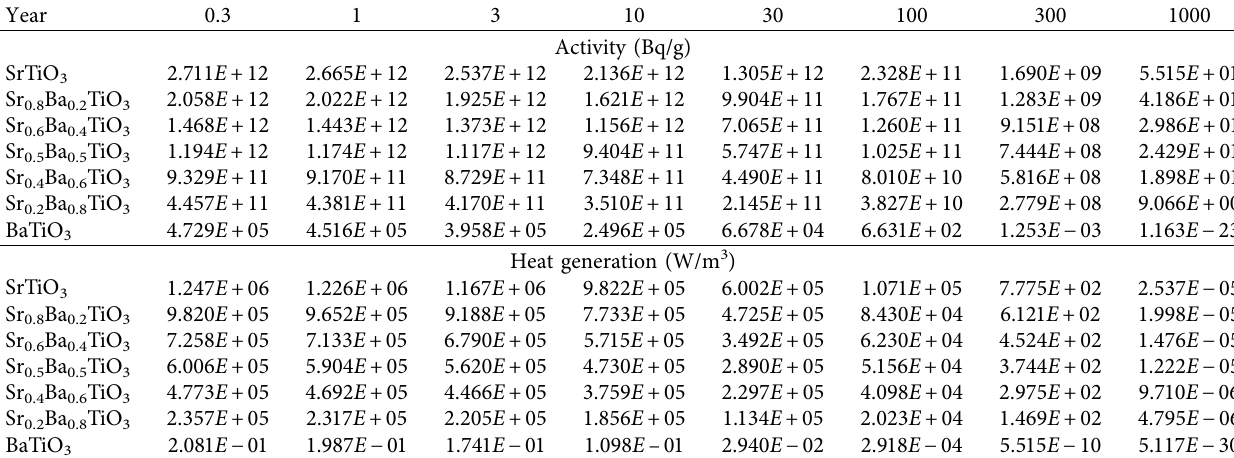
Figure 4: Radiological characteristics of Sr waste form according to Sr/Ba ratio ((b) and (d) correspond to magnified graphs of (a) and (c), respectively). Table 5: Radiological characteristics of Sr waste form according to Sr/Ba ratio.